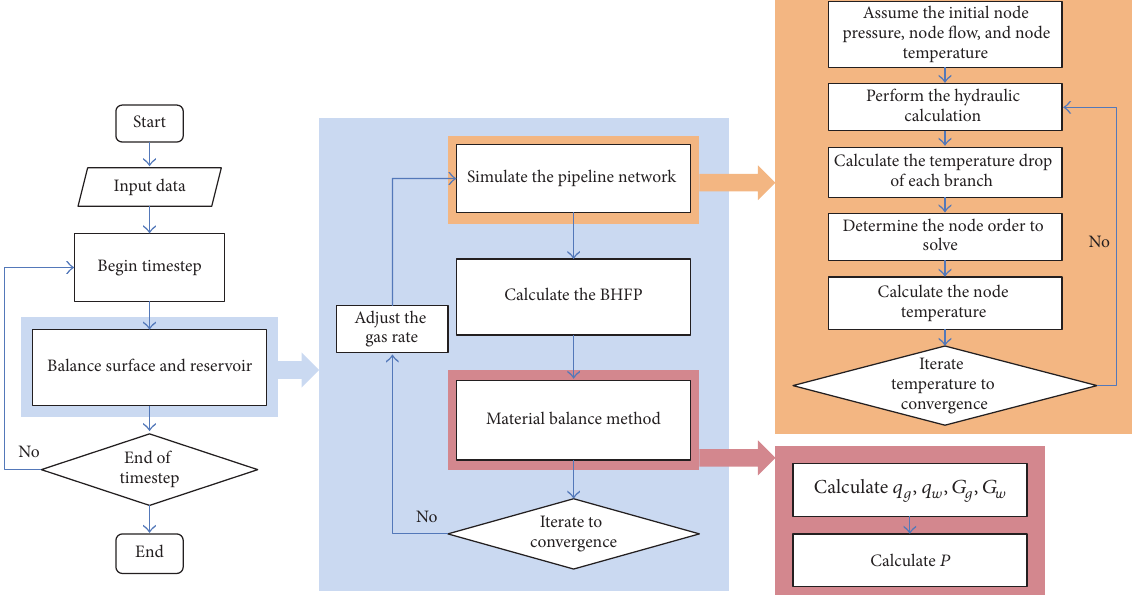
Figure 3: CBM reservoir/surface coupling